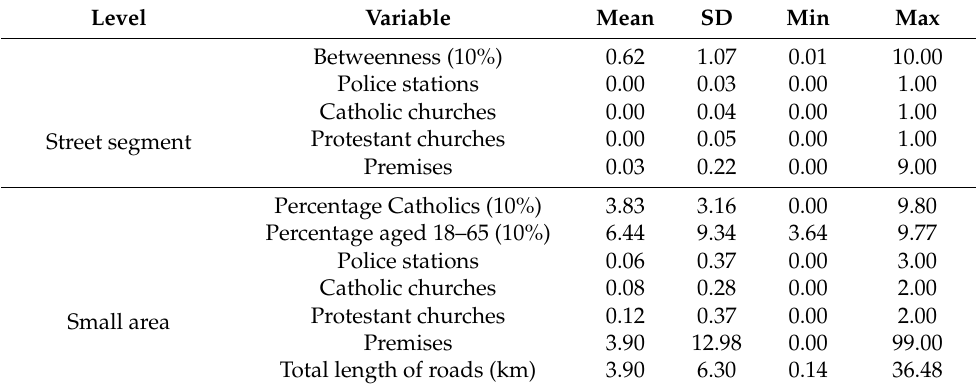
Table 1. Summary statistics of the independent